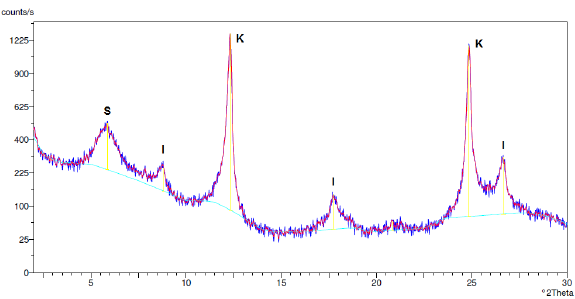
Figure 4: X-ray diffraction of the soil sample ( < 2 µ